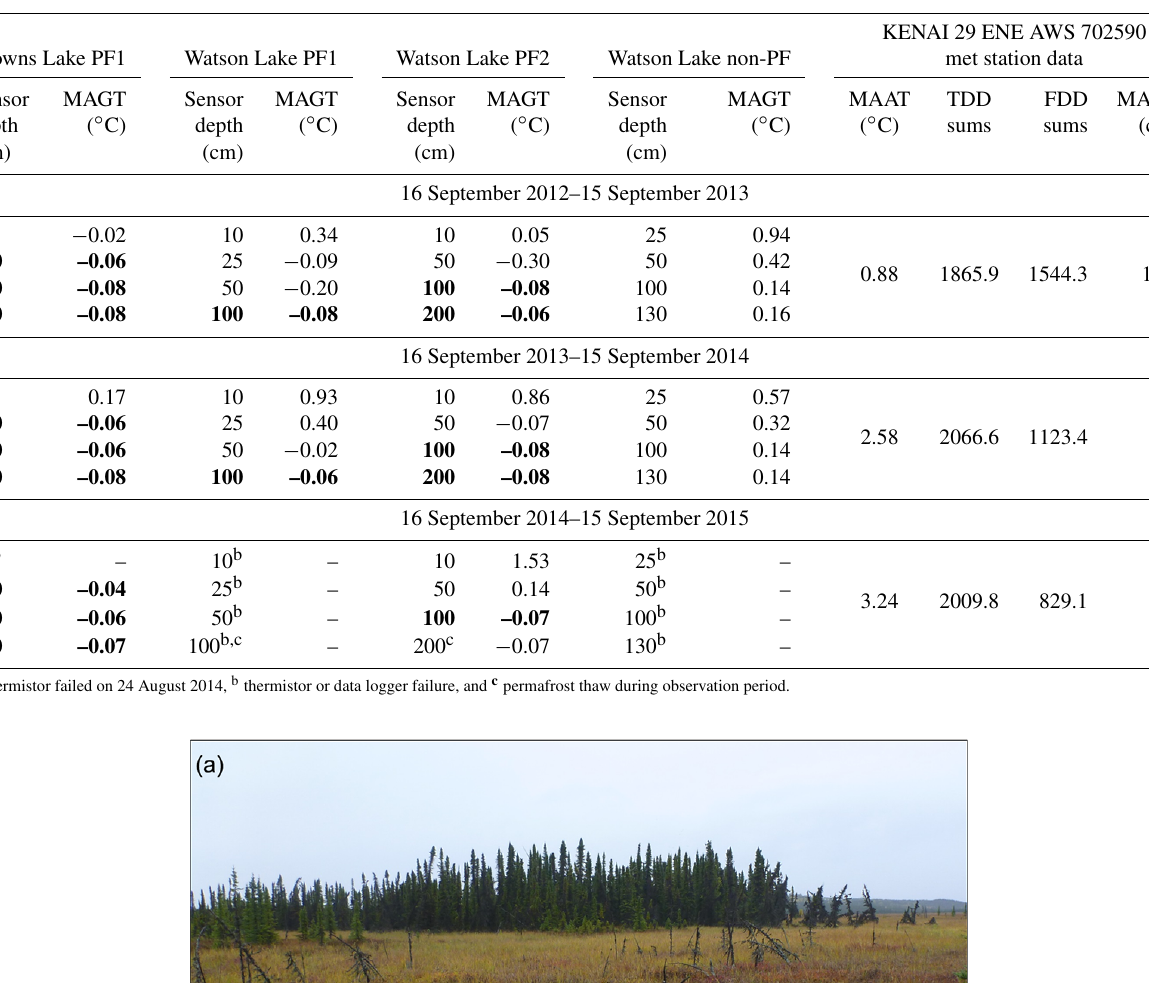
Table 1. Mean annual ground temperature (MAGT) data for four observation sites in the Kenai Peninsula lowlands. Browns Lake PF1, Watson Lake PF1, and Watson Lake PF2 represent permafrost plateaus and the Watson Lake non-PF site represents a black-spruce-forested non-plateau site. Sensor depths that were perennially frozen in a given year are in bold. Mean annual air temperature (MAAT), thawing and freezing degree days (TDD and FDD), and average winter snow depth (MASD) are from the MRC station (Kenai 29 ENE-AWS 702590).